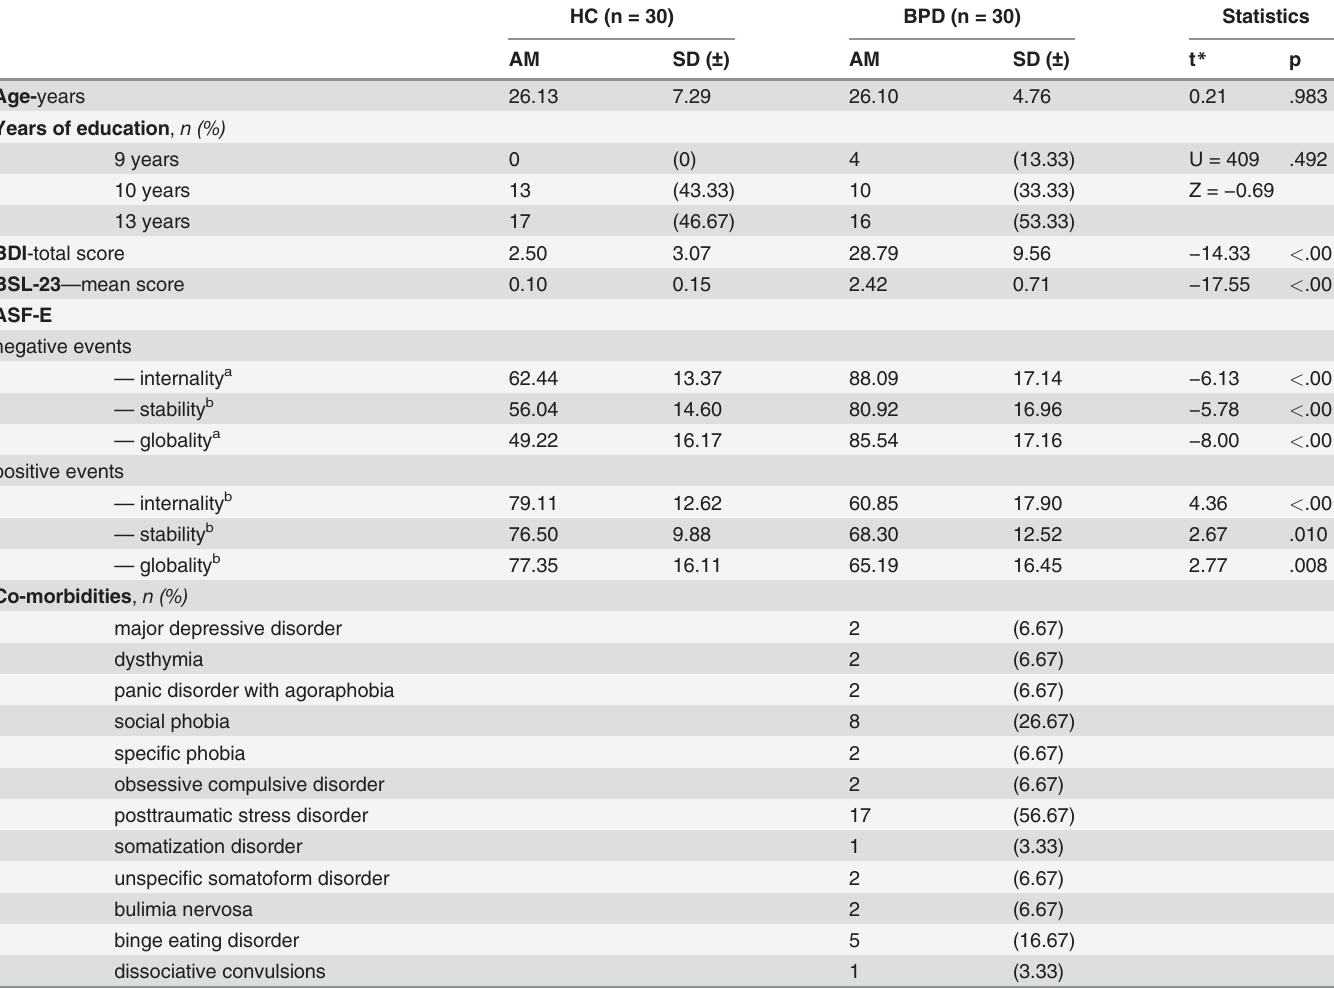
Table 1. Demographic and clinical variables in healthy control participants (HC) and patients with Borderline Personality Disorder (BPD). HC (n =